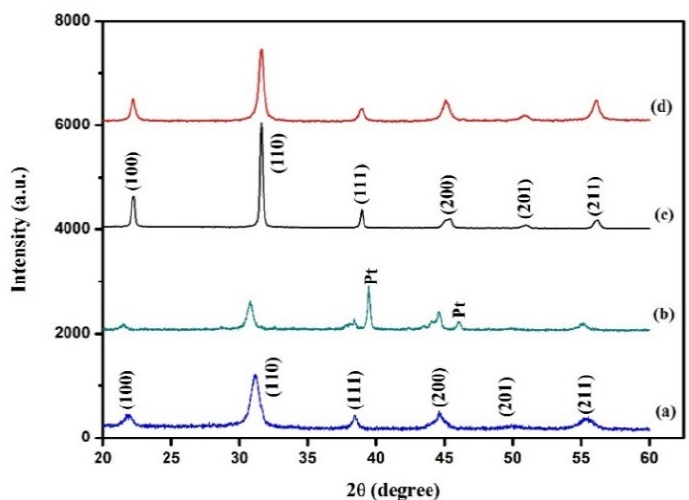
Figure 5. XRD patterns of the ( a ) PZT powder, ( b ) 600 °C annealed PZT film, ( c ) PMN–PT powder, and ( d ) 600 °C annealed PMN–PT film. Table 1. Comparison between PZT and PMN–PT.